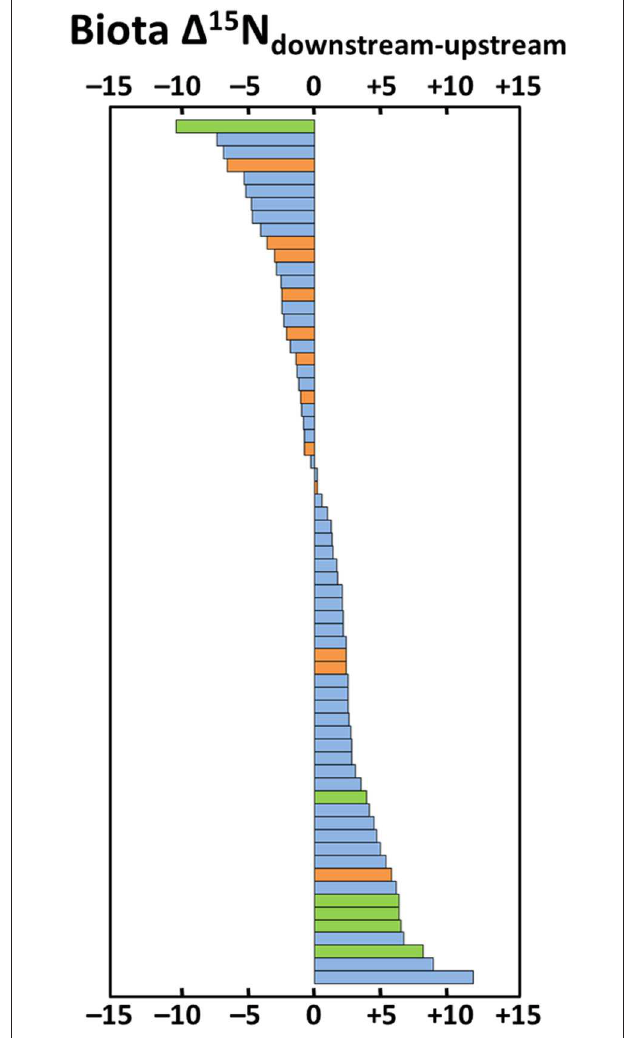
FIGURE 9 | Effect of anthropogenic nitrogen loading on aquatic flora and fauna δ 15 N in rivers, including seston (green), invertebrates (blue), and fish (orange). Bars represent the difference between mean δ 15 N for a given biota upstream and downstream of an anthropogenic nitrogen source (e.g., urban, industrial, or agricultural effluent). Negative shifts in δ 15 N can occur when over-abundant DIN favors greater discrimination against 15 N during assimilation by primary producers (see Electronic Supplementary Information 2 ; data from Harrington et al., 1998; Wayland and Hobson, 2001; DeBruyn and Rasmussen, 2002; Gustin et al., 2005; Ulseth and Hershey, 2005; Finlay and Kendall, 2007; Brown et al., 2011; di Lascio et al., 2013; Morrissey et al., 2013; Atkinson et al., 2014; Loomer et al., 2015; Robinson et al., 2016; data in Electronic Supplementary Information 4